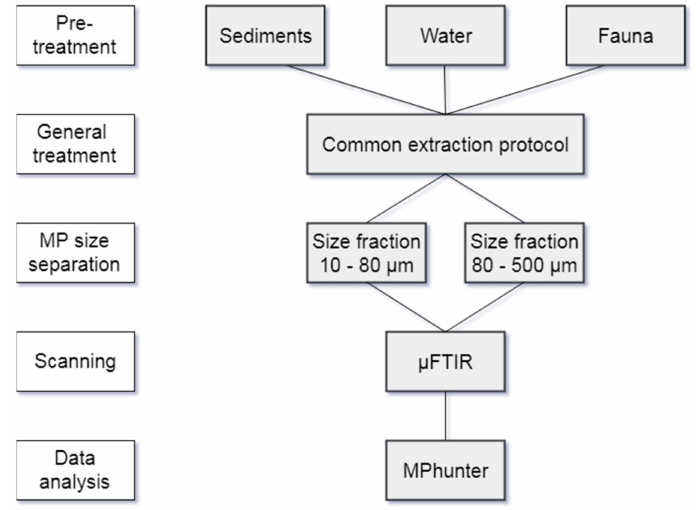
Figure 2. Protocol for treatment and analysis of